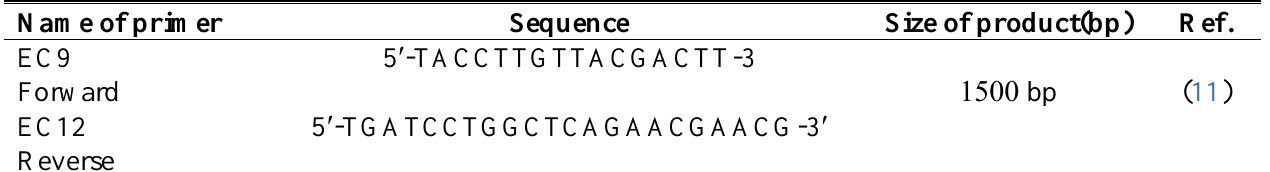
Table 1. The primers